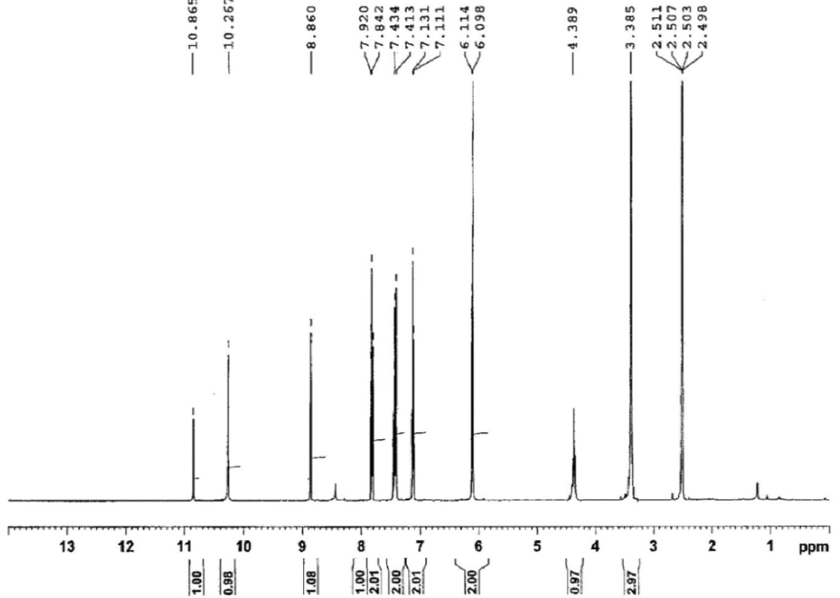
Figure 3. 1 H-NMR spectra of